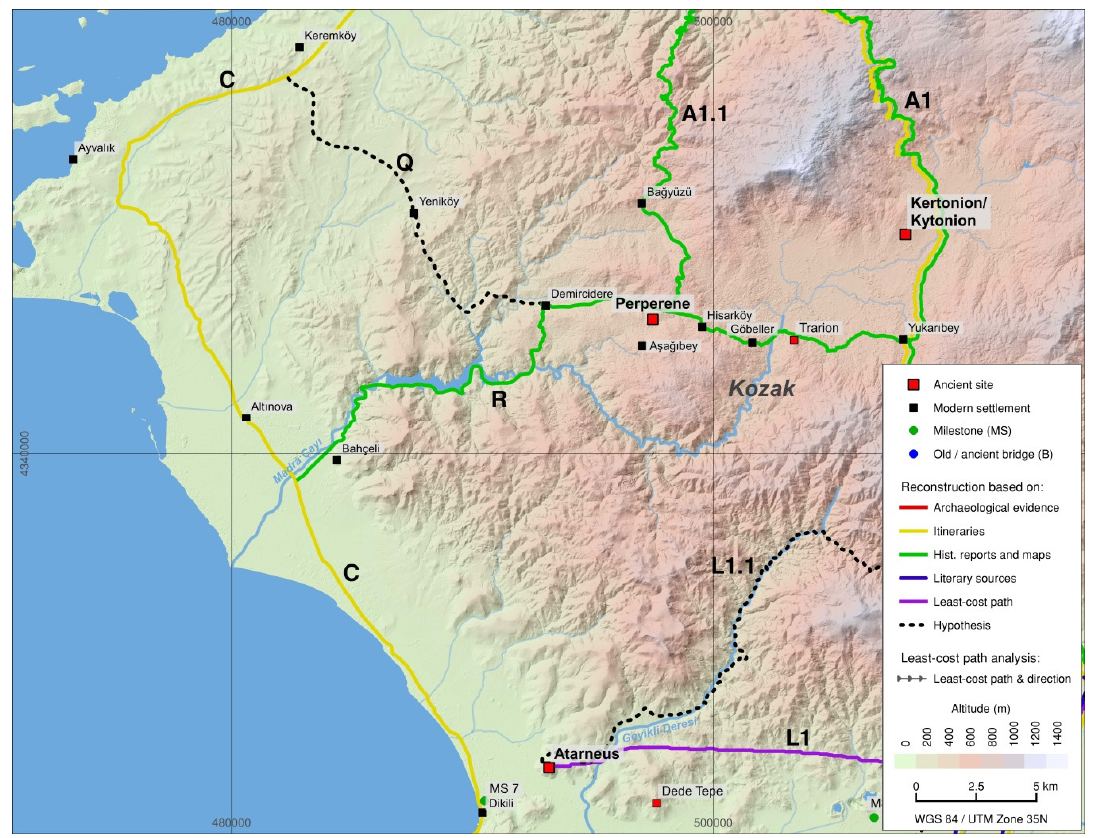
Figure 26. Reconstructed routes between Perperene and the ancient coastal road.